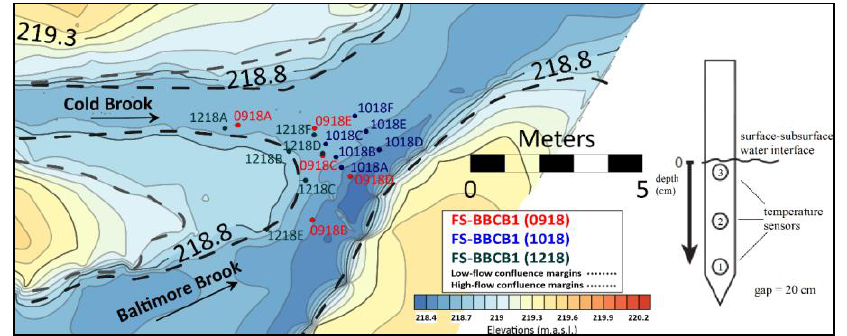
Figure 3. Locations of temperature rods used for vertical hydraulic gradient tests, for FS-BBCB1 and the temperature rod setup (right).